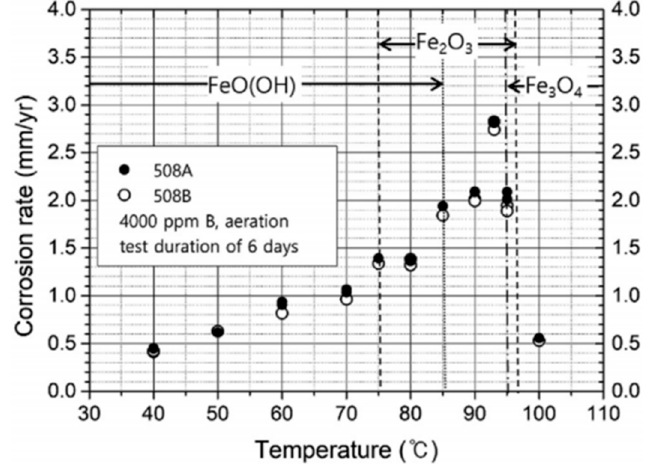
Figure 3. Corrosion rates and corrosion products of 508A and 508B in boron concentration of 4000 ppm [81].